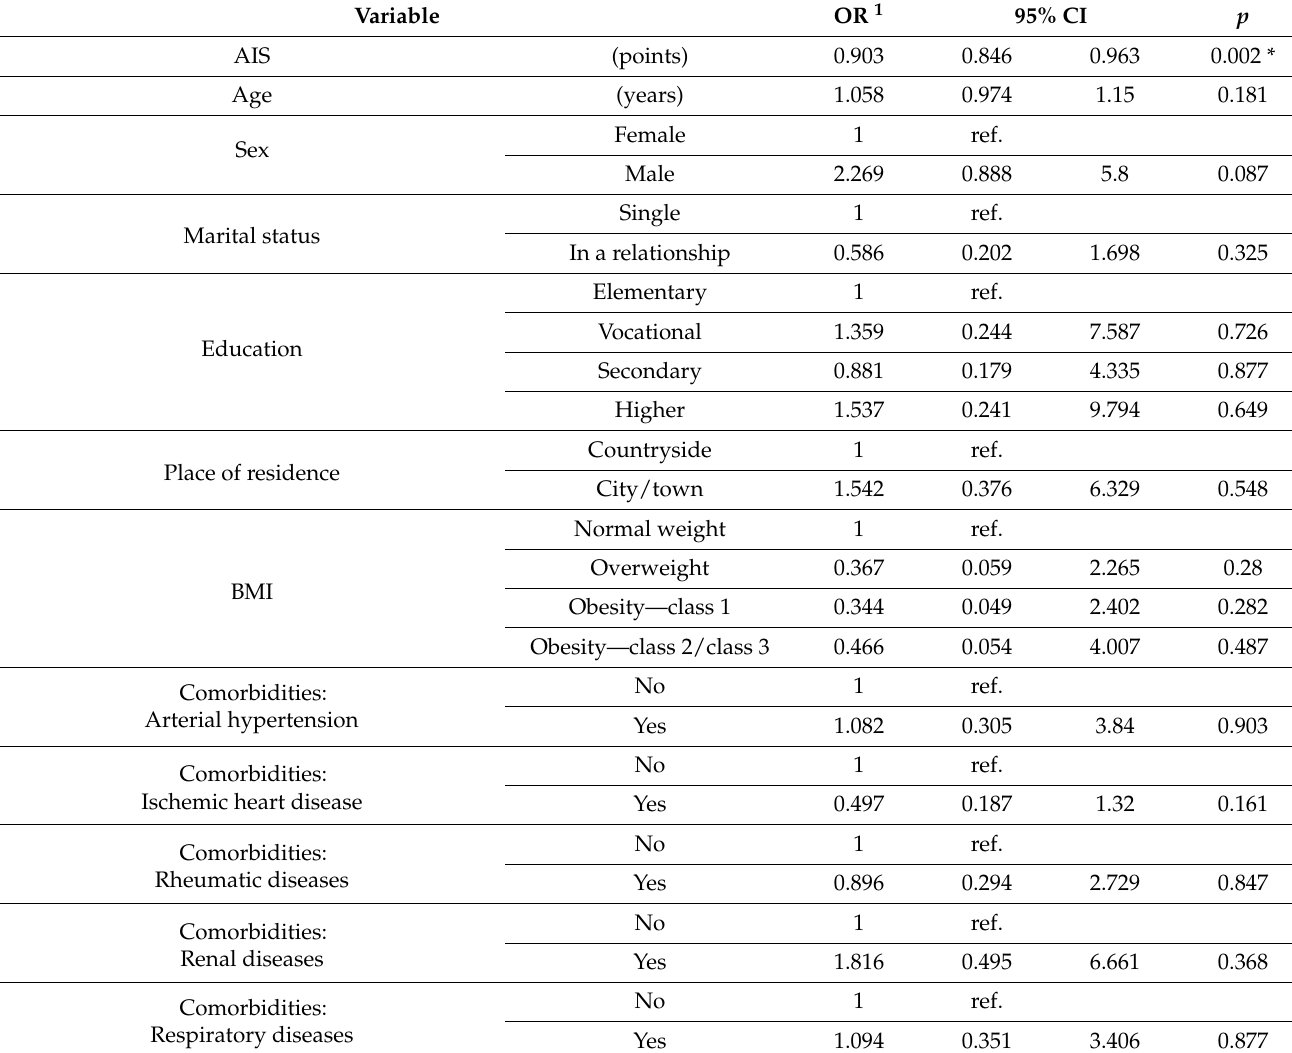
Table 5. Non-adherence predictors—multivariate logistic regression